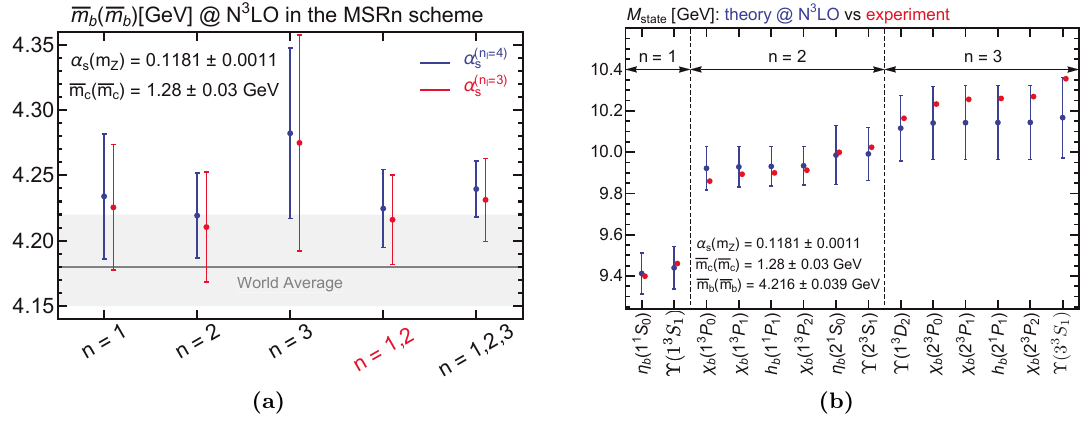
Figure 9. Left panel: bottom quark mass determined at N 3 LO in the MSRn scheme with n (blue) and n ‘ = 3 (red) (cid:13)avors from global (cid:12)ts to n = 1, n = 2, n = 3, n = 1 ; 2 and n = 1 ; 2 ; 3 states. Right panel: prediction of the bottomonium energy levels at N 3 LO (in blue) vs the corresponding experimental values (in red). Experimental error bars are too small to be